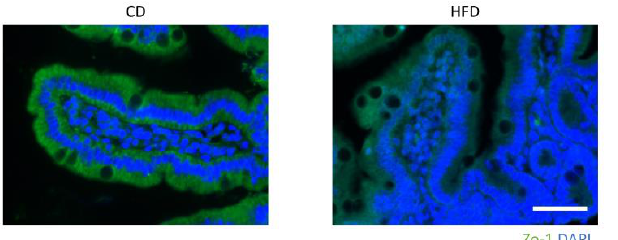
Figure 3. Representative immunohistological ZO-1 stained images of the upper small intestine of HFD- and CD-fed mice. Scale bar: 50 µ m.